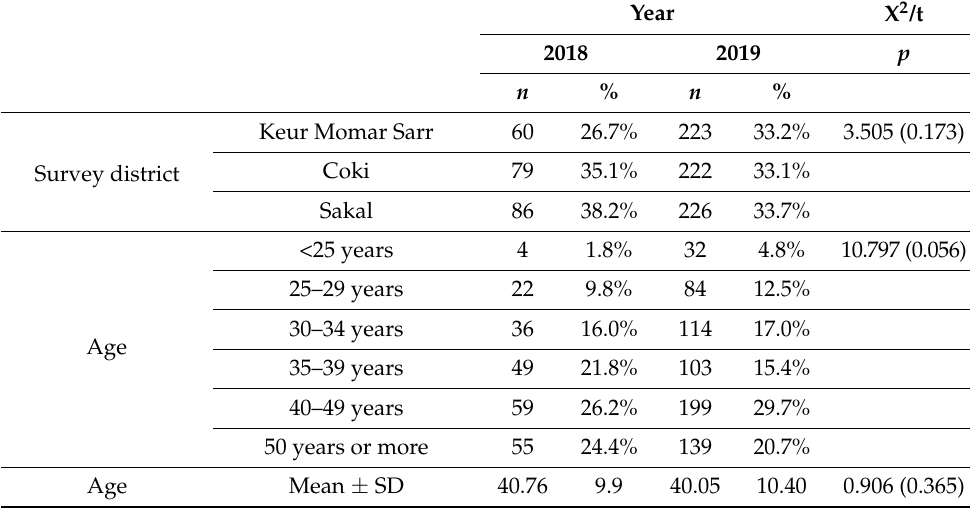
Table 2. Characteristics of the participants